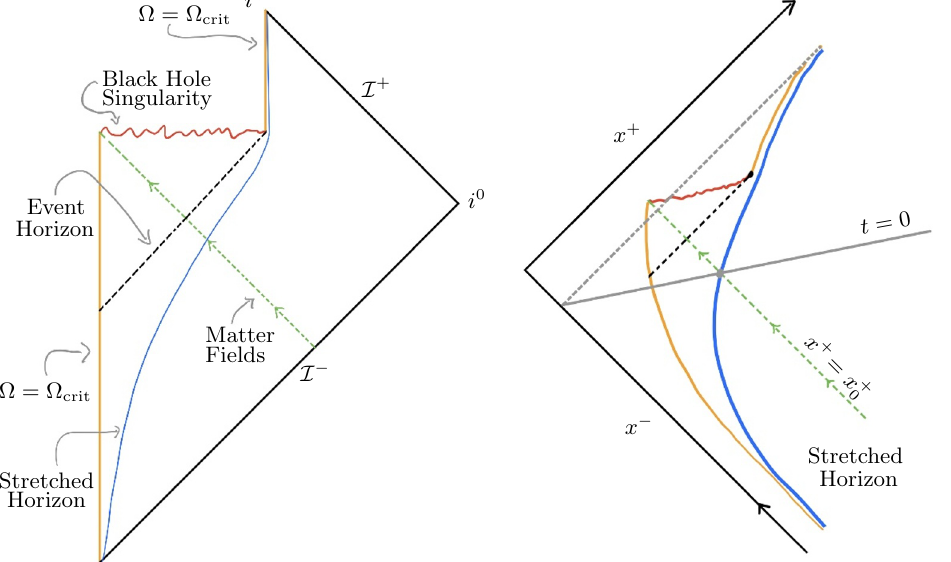
Figure 5 . Left panel: Penrose diagram depicting the life cycle of evaporating black hole formed by collapse. Right panel: the corresponding Kruskal diagram with the same color coding. The gray line denotes a curve of equal tortoise time t